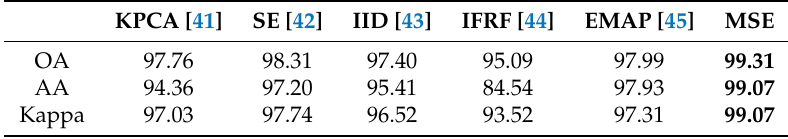
Table 5. Classification quality of the proposed MSE with different feature extractors.